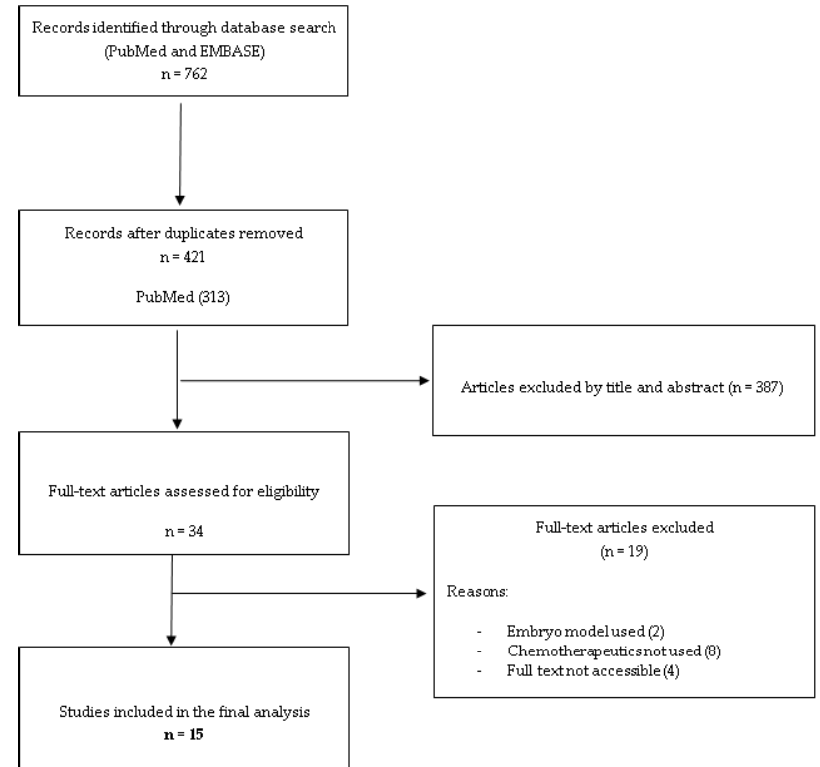
Figure 1. PRISMA (Preferred Reporting Items for Systematic Reviews and Meta-Analyses) flow-chart.